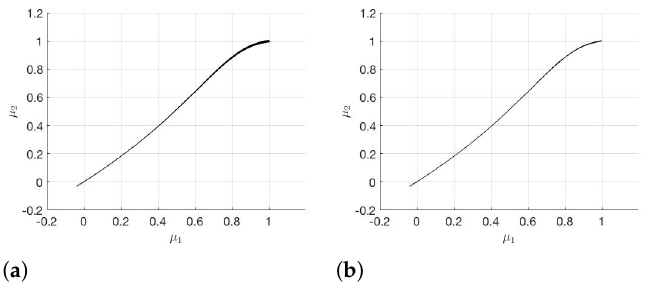
Figure 4. ( a ) P (cid:96) and ( b ) P (cid:96) generated with the modified subdivision algorithm. 2 1 The runtime, number of boxes and number of function and gradient evaluations needed in iteration step 10, 15, 20, and 25 are shown in Tables 1–5. The total runtime and number of function and gradient evaluations needed for the different methods and the speed-up are shown in Table